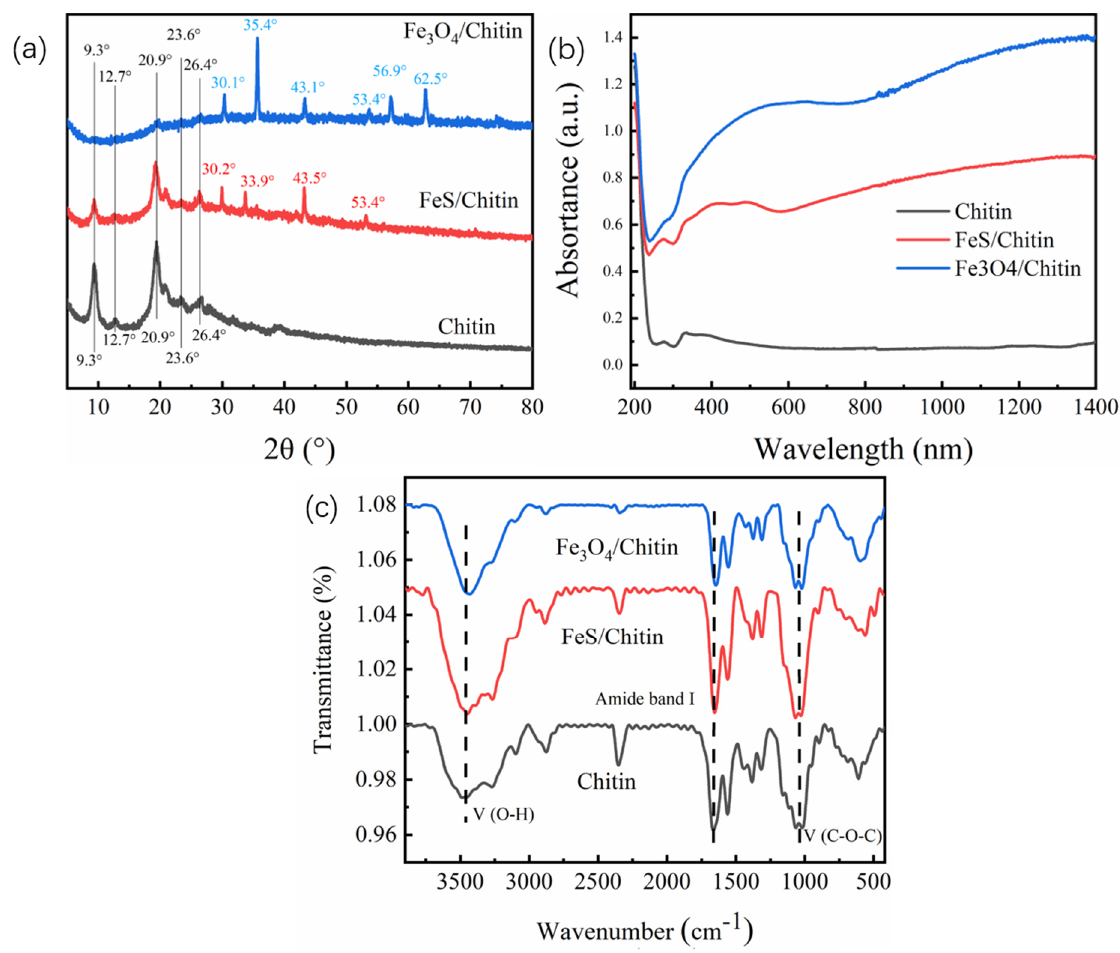
Figure 4. ( a ) XRD, ( b ) UV − Vis − NIR DRS and ( c ) FT − IR spectra of chitin, FeS/chitin and Fe 3 O 4 /chitin films.